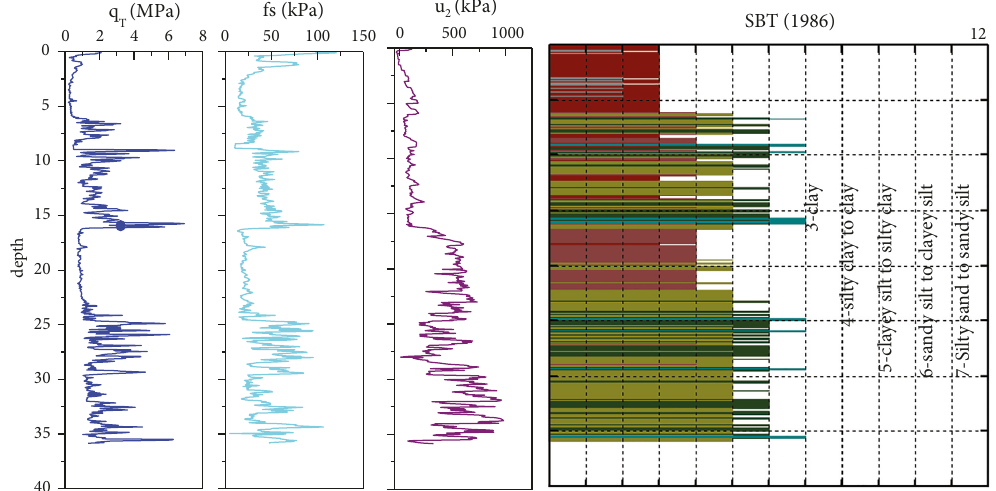
Figure 4: Illustrative profile of soil classification of s05 using Robertson et al.’s method [15].